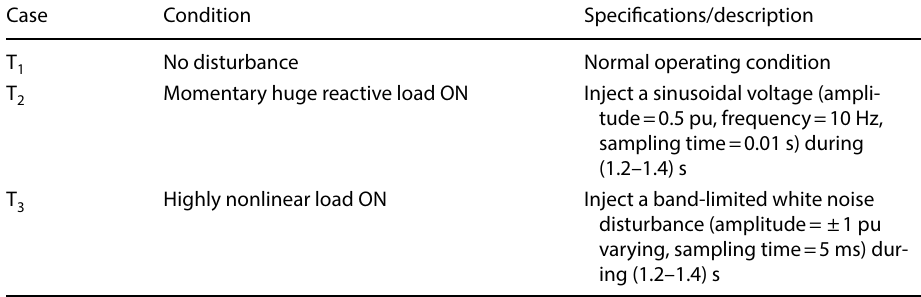
Table 10 Test cases implemented for comparative